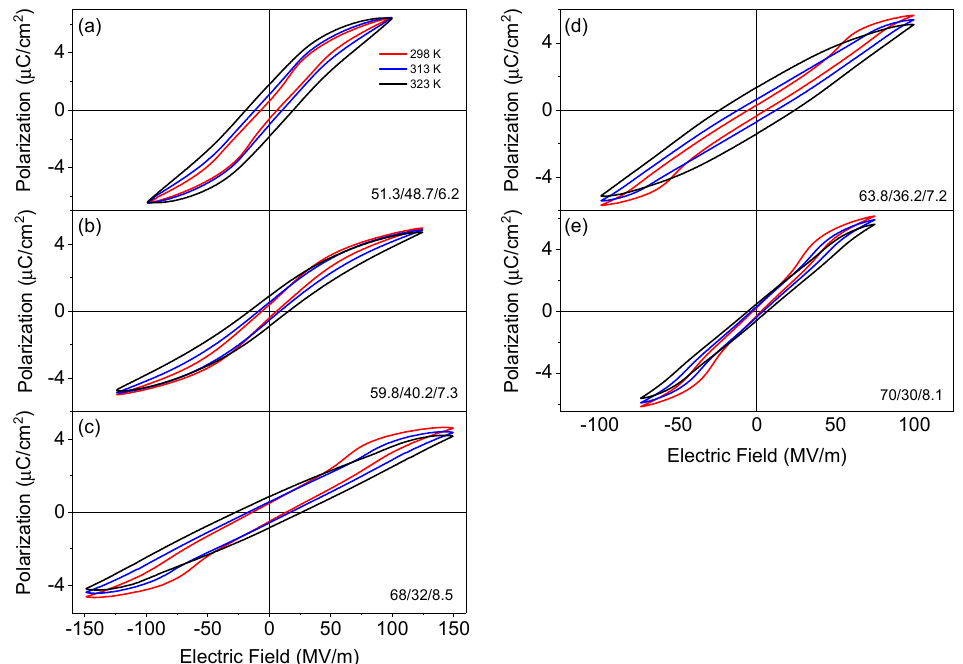
Figure 4. Polarization hysteresis loops of the P(VDF-TrFE-CFE) 51.3/48.7/6.2 ( a ), 59.8/40.2/7.3 ( b ), 68/32/8.5 ( c ), 63.8/36.2/7.2 ( d ), and 70/30/8.1 ( e ) films measured as a function of temperature at 10 Hz (triangular wave) on cooling.